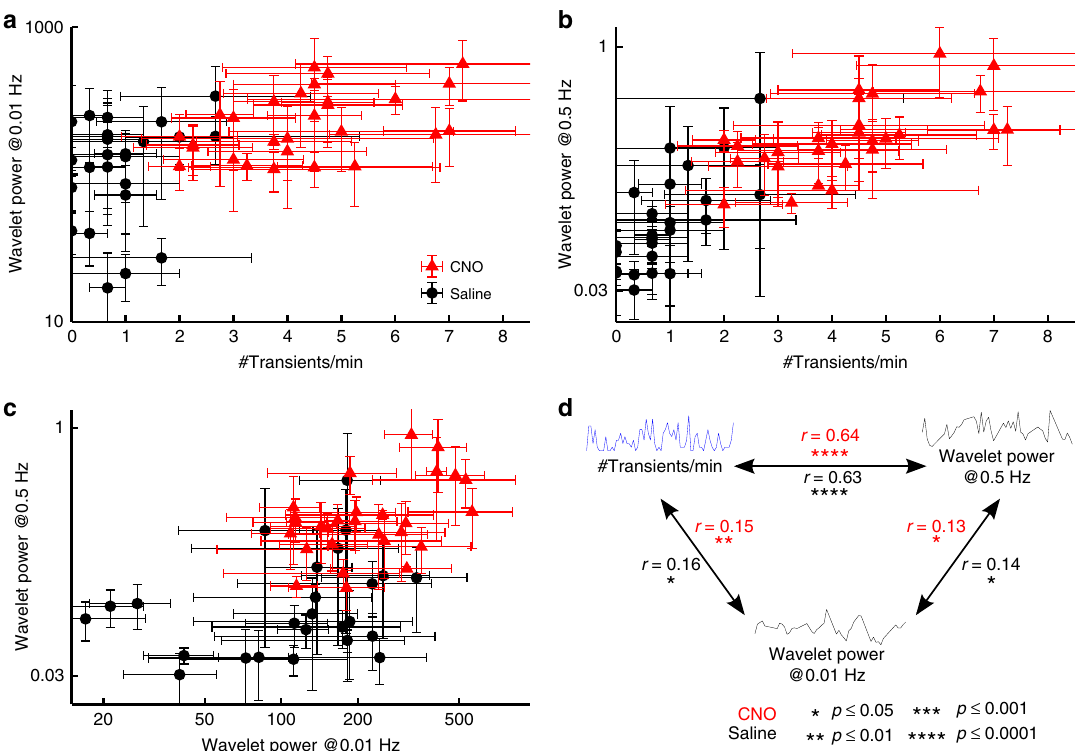
Fig. 8 Correlations between transient rates and high as well as low-frequency power. a – c Correlations of the logarithm of low-frequency power (0.01 Hz) with transient rate ( a ), the logarithm of high-frequency power and transient rate ( b ), and the logarithm of low and high-frequency power ( c ). Data points are shown for each one-minute time interval as mean ± SEM for each group (red triangles = hM3D Gq DAT + CNO, n CNO = 4; black circles = hM3D Gq DAT + Saline, n Saline = 3). d Pearson product moment correlation coef fi cients, r, were calculated within each group (in red for the hM3D Gq DAT + CNO group: df = 296, * = p ≤ 0.05 ( t > 1.97), ** = p ≤ 0.01 ( t > 2.59), *** = p ≤ 0.001 ( t > 3.32), **** = p ≤ 0.0001 ( t > 3.94); in black for the hM3D Gq DAT + Saline group: df